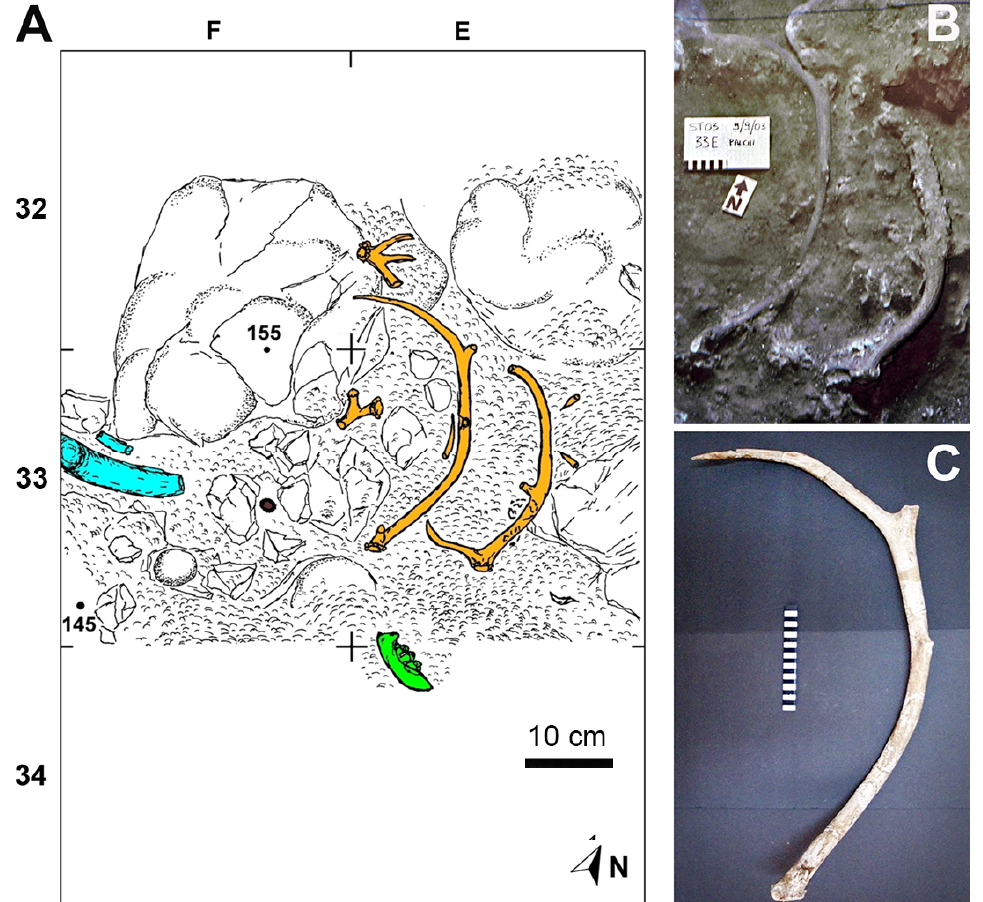
Figure 9. Drawing ( A ) and photo ( B ) with location of the two antlers (orange) of Cervus elaphus siciliae in the trench of the San Teodoro Cave before recovering. Light blue: tusks of elephant; green: remains of Bos ; ( C ) photo of one antler. Scale bar 10 cm. Numbers and letters along the sides of A refer to the excavation grid visible in Figure 7 (from [46], modified).